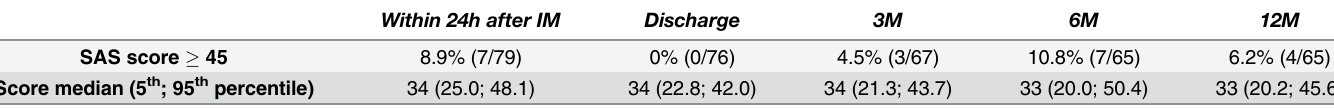
Table 2. Occurrence of positivity of questionnaire